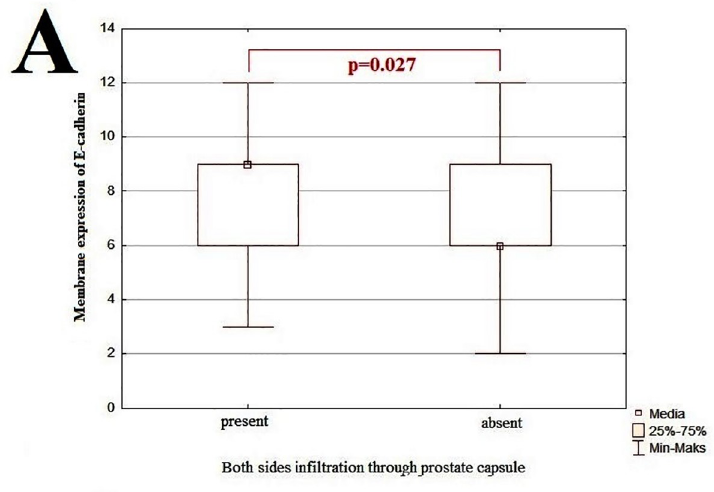
Fig 4. The graphic representation of results for membrane expression of E-cadherin examined by IHC technique. The x-axis shows individual clinicopathological features and the y-axis shows IRS score values for IHC staining. The p- value < 0.05 was considered as a statistically significant. Correlation between membrane expression of E-cadherin and both sides infiltration of the prostate capsule (A).